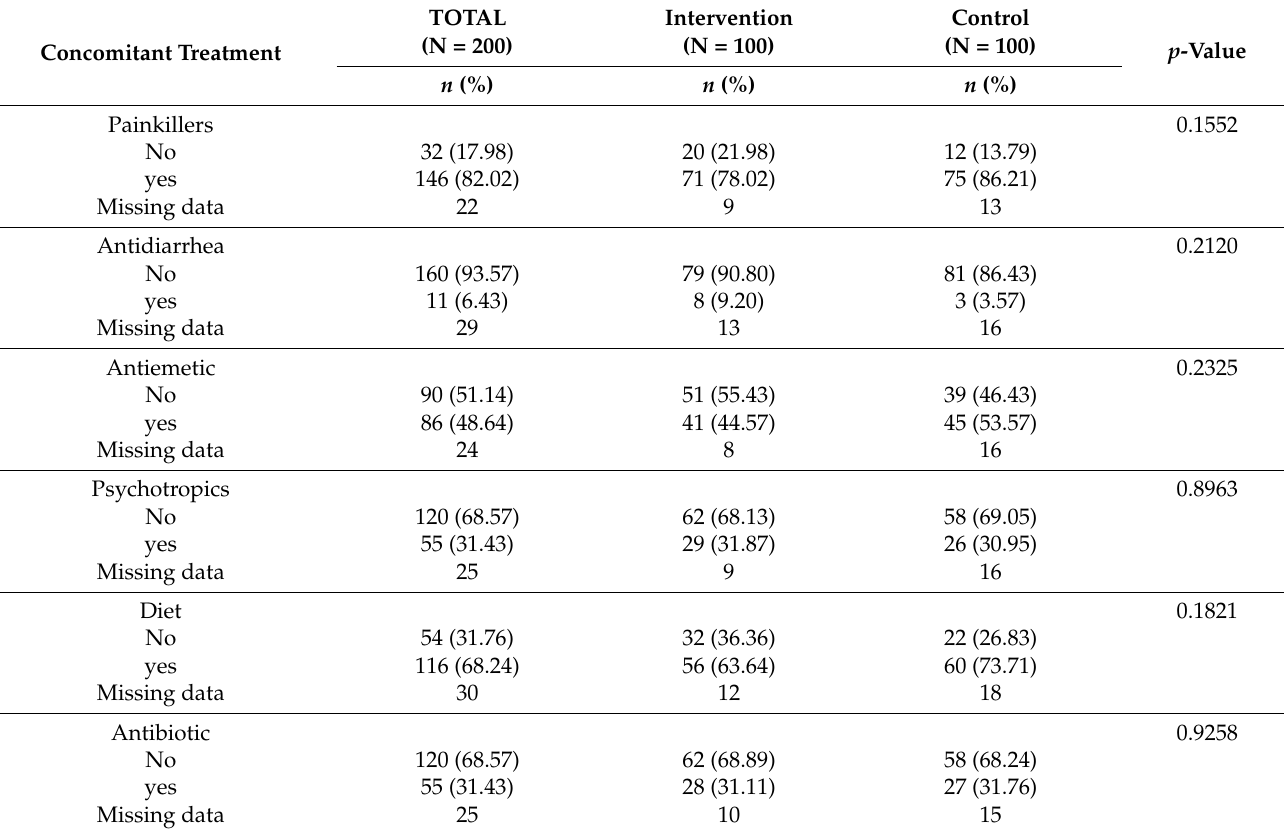
Table 5. Concomitant